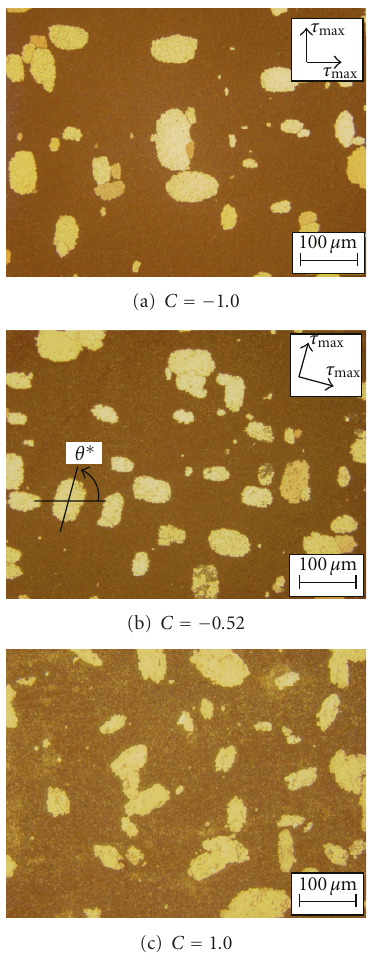
Figure 8: Grown grains occurred at the copper foil.